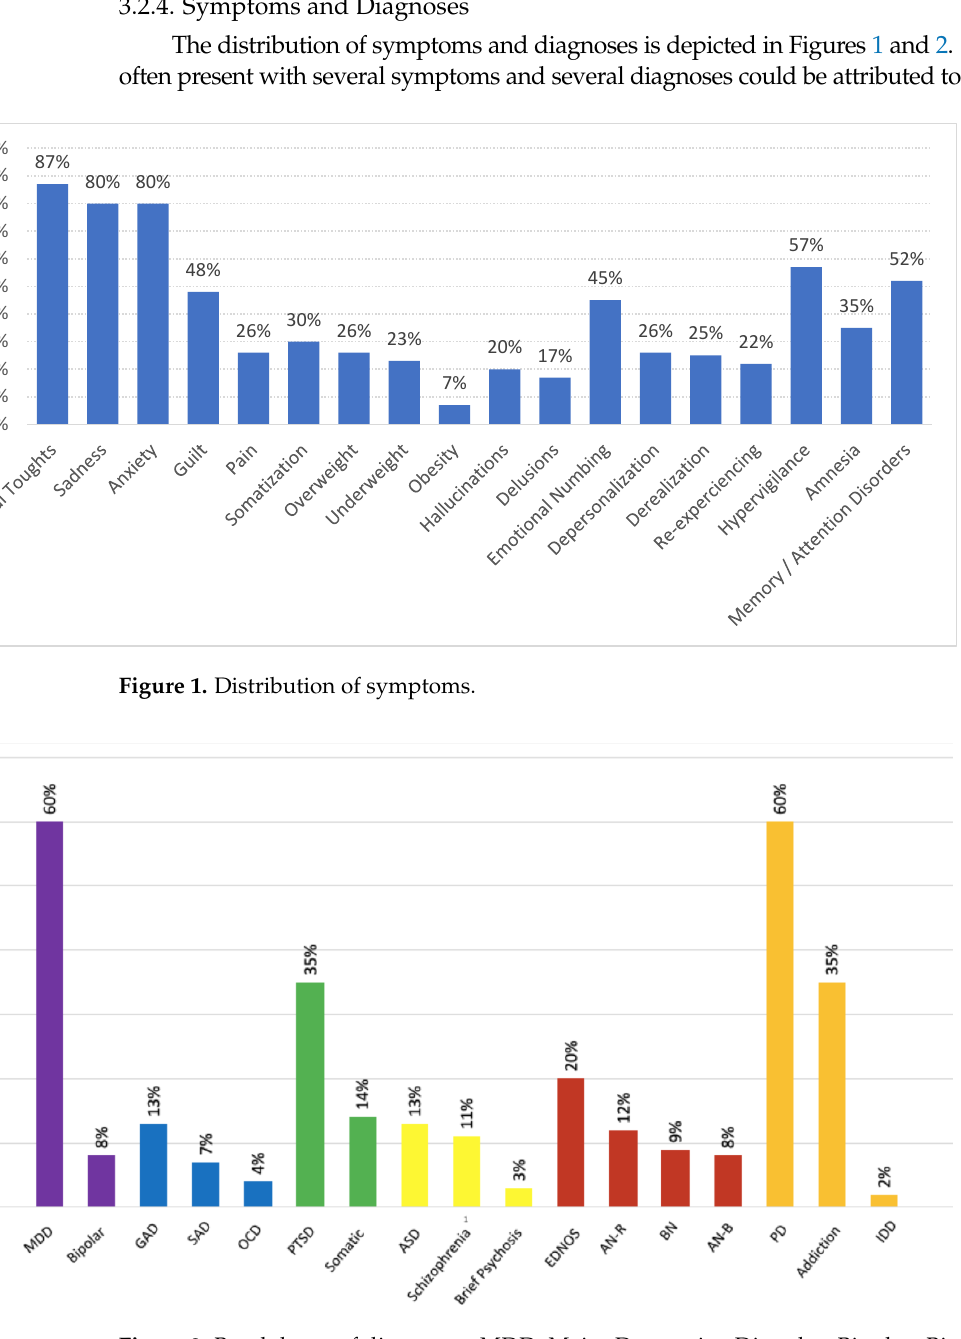
Figure 2. Breakdown of diagnoses. MDD: Major Depressive Disorder; Bipolar: Bipolar Disorder; GAD: General Anxiety Disorder; SAD: Social Anxiety Disorder; OCD: Obsessive-Compulsive Disorder; PTSD: Post-Traumatic Stress Disorder; Somatic: Somatic Symptom and Related Disor- ders; ASD: Autism Spectrum Disorder; Brief Psychosis: Brief Psychotic Disorder; EDNOS: Eating Disorder Not Other Specified; AN-R: Anorexia Nervosa Restrictive Type; BN: Bulimia Nervosa; AN-B: Anorexia Nervosa-Binge-Eating/purging Type; PD: Personality Disorders; Addiction: Ad- dictive Disorders; IDD: Intellectual Developmental Disorder.